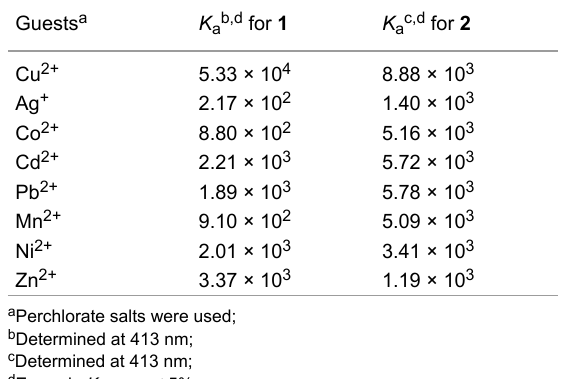
Table 1: Association constants ( K a in M − 1 ) for 1 and 2 with the metal ions by fluorescence method. Guests